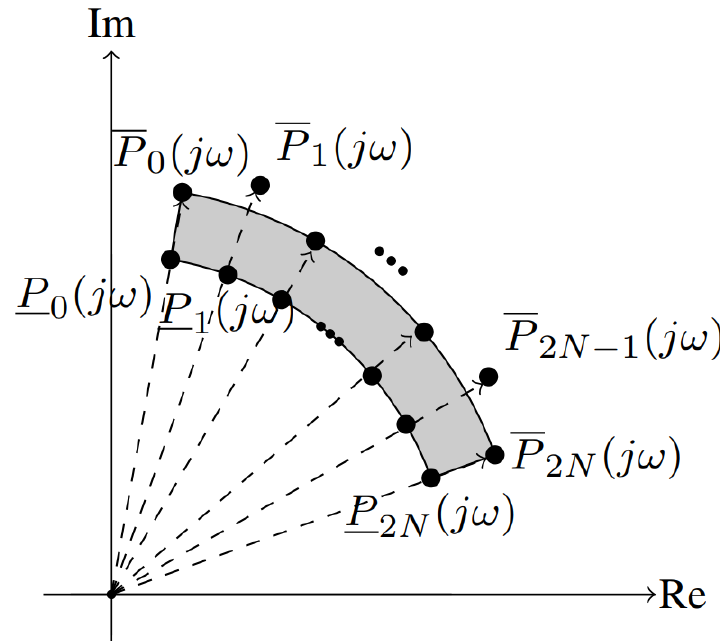
Figure 1. The value set of ∆ 2 ( j ω ) and the vertices P h ( j ω ) and P h ( j ω )